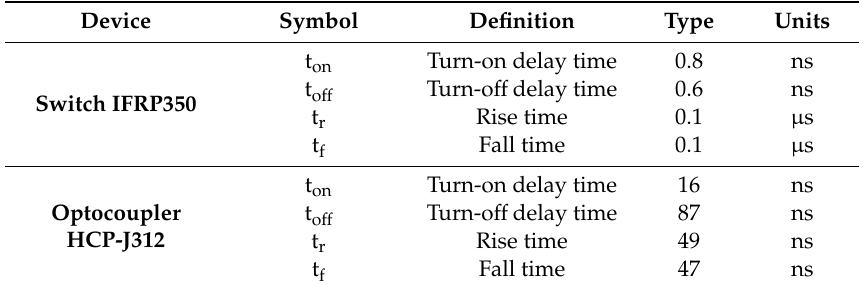
Table 2. Commutation time of the solid-state switch (N-channel MOSFET) and optocoupler.